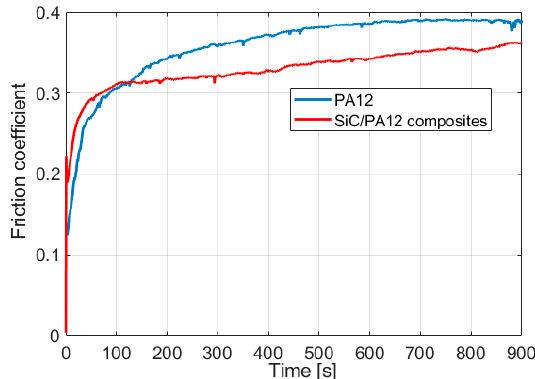
Figure 5. Evolution of the friction coefficient during the sliding tests.